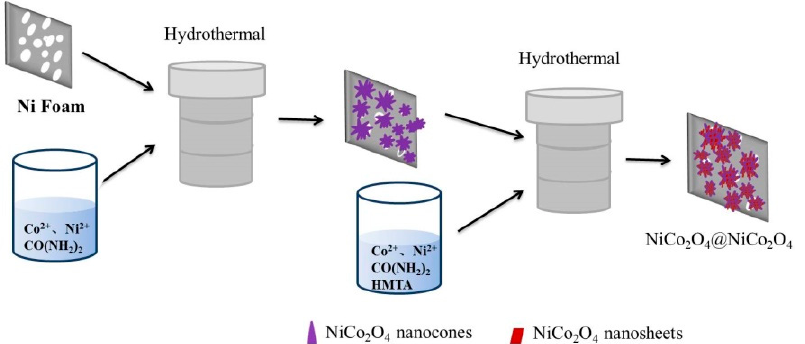
Figure 1. A schematic illustration of the core-shell NiCo 2 O 4 @NiCo 2 O 4 synthesis strategy.